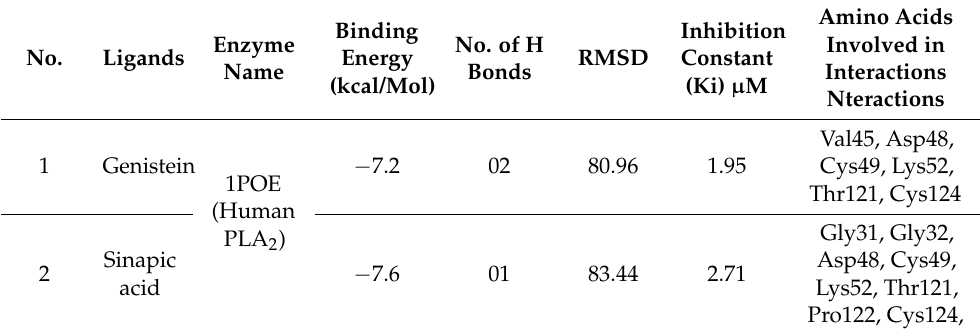
Table 1. The binding energy, H- bonds and hydrophobic interactions of genistein and sinapic acid with human sPLA 2 -IIA (PDB ID: